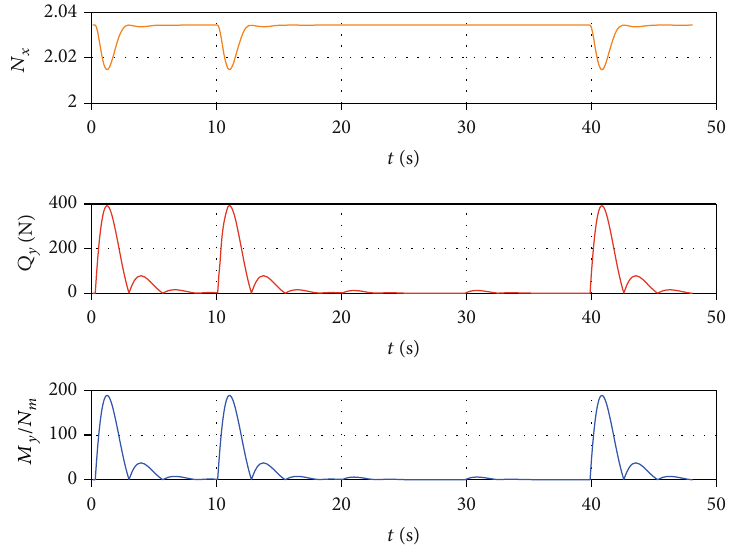
Figure 9: Time histories of the maximum axial load, shear force, and bending moment with improved PSO.